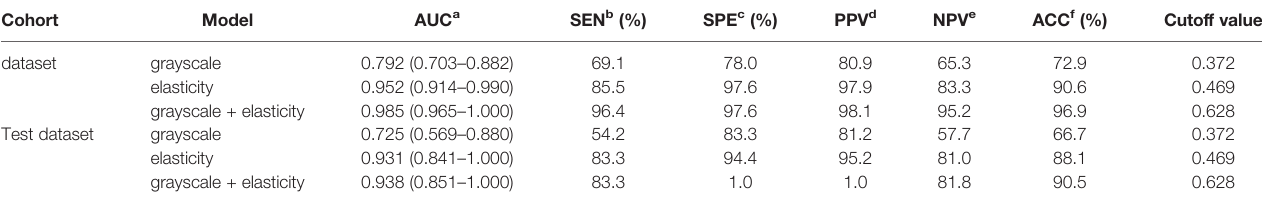
TABLE 3 | Performance of the sequences models.